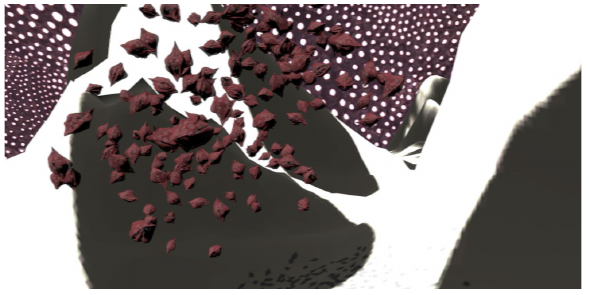
Figure 6. AudioVirtualizer scene 2b